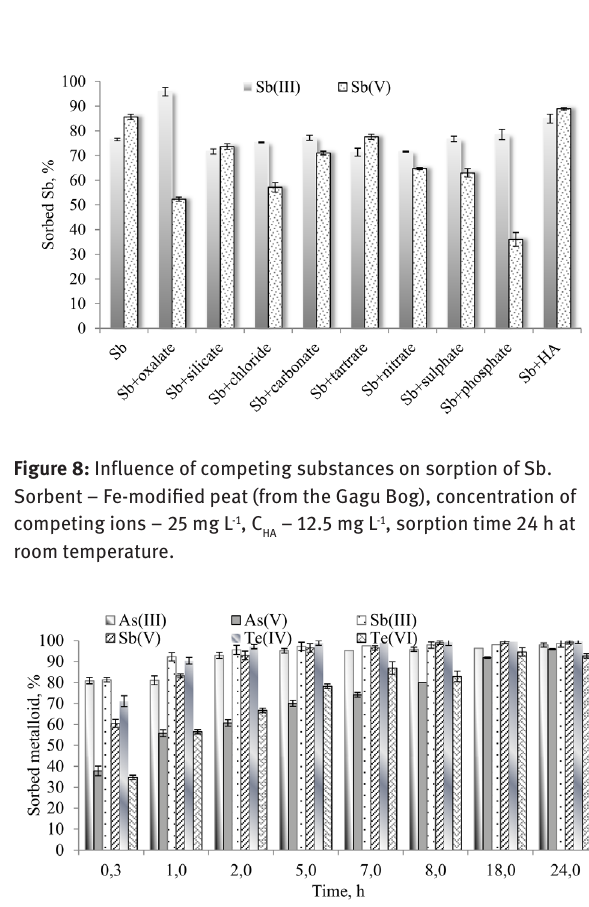
Figure 9: Sorption kinetics study of metalloids on Fe-modified peat, initial concentrations of As and Te is 100 mg L -1 , Sb – 200 mg L -1 , at room